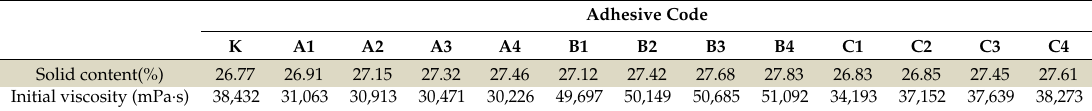
Table 3. Solid content and initial viscosity.